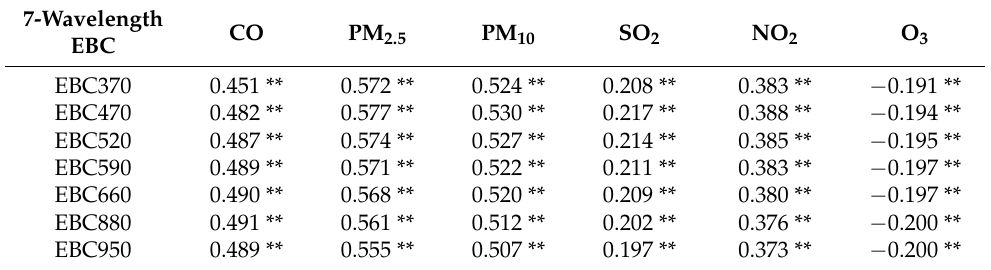
Table 1. Pearson correlation coefficient of multichannel EBC and atmospheric